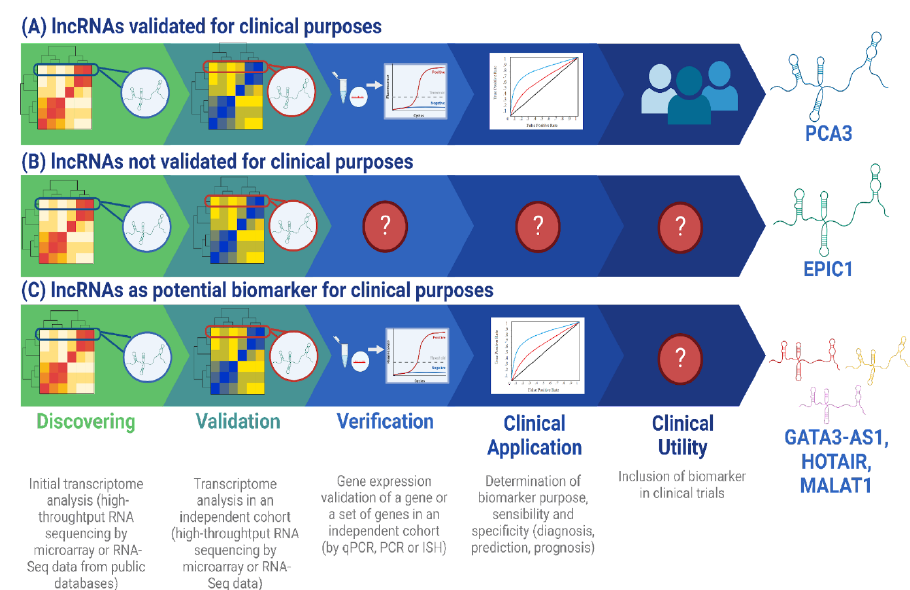
Figure 1. Workflow for lncRNA validation as biomarkers with clinical utility and application. The process of implementing a lncRNA-based biomarker consists of 5 principal steps: discovery,